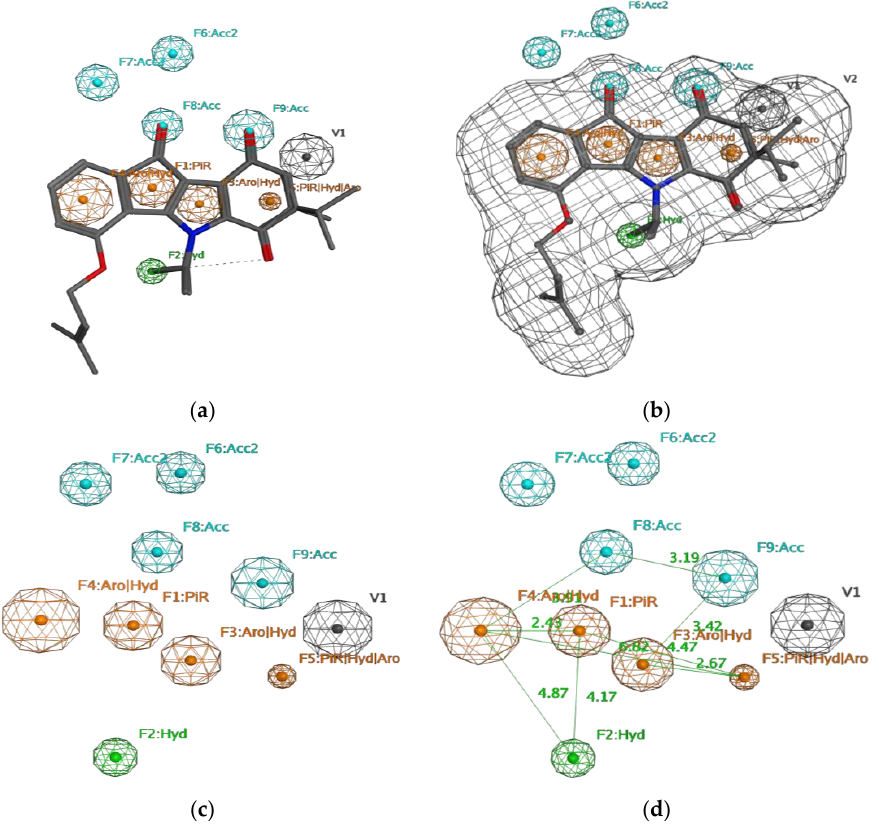
Figure 2. The developed pharmacophore model. ( a ) Alignment of common feature pharmacophore model with training set; ( b ) Alignment of common feature pharmacophore model with training set with occupied volume; ( c ) Common feature pharmacophore model of indeno[1,2- b ]indole-type CK2 inhibitors; ( d ) Common feature pharmacophore model with the distance constraints. Acc : H-bond acceptor, Acc 2 : H-bond acceptor projection, Aro : Aromatic center, Hyd : Hydrophobic centroid, PiR : π ring center.